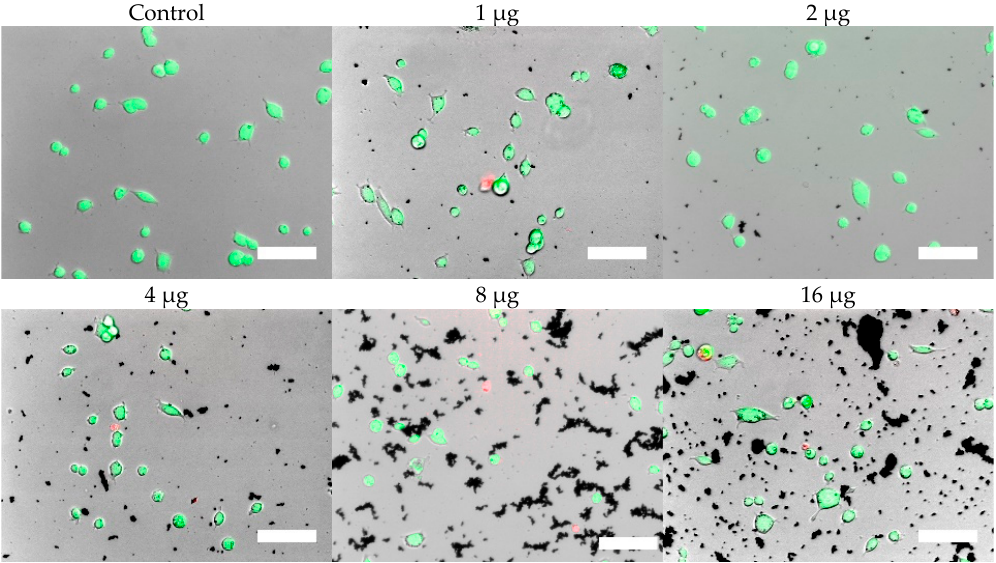
Figure 7. LIVE/DEAD assay results of PC12 cells treated with hydrophobic iron oxide nanoparticles after 24 h. Calcein (green) indicates live cells while ethidium homodimer-1 (red) indicates dead cells. Scale bar = 50 µm.